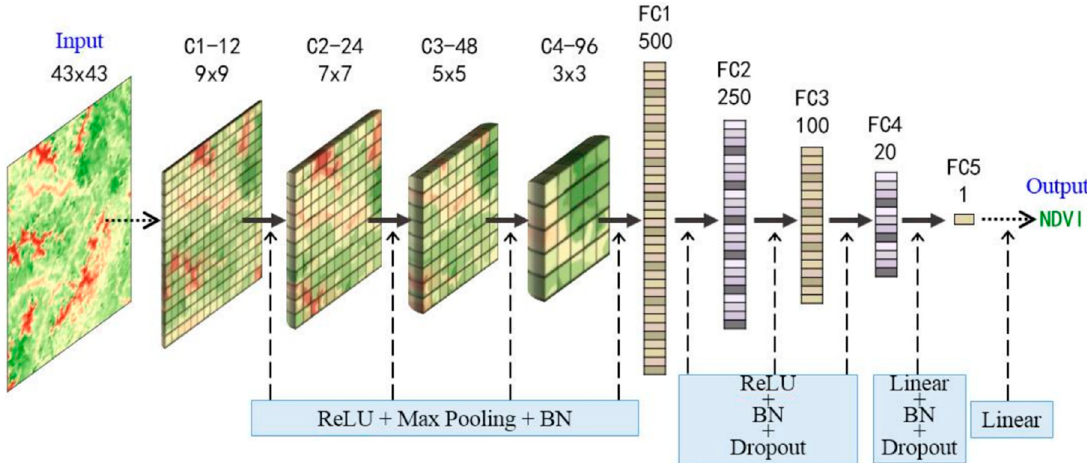
Figure 2. The architecture of proposed CNNs model for reconstructing multi-source NDVI. C1–C4 and FC1–FC5 represented convolutional layers and fully connected layers, respectively.